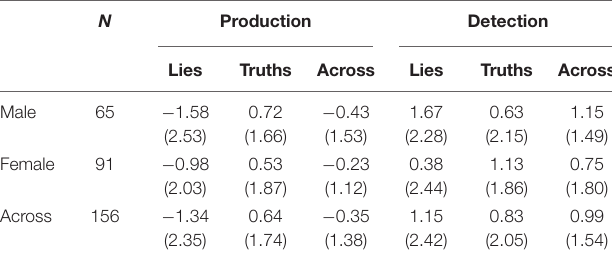
TABLE 8 | Means (and SDs) of performance indexes separated for production and detection activities and gender. N